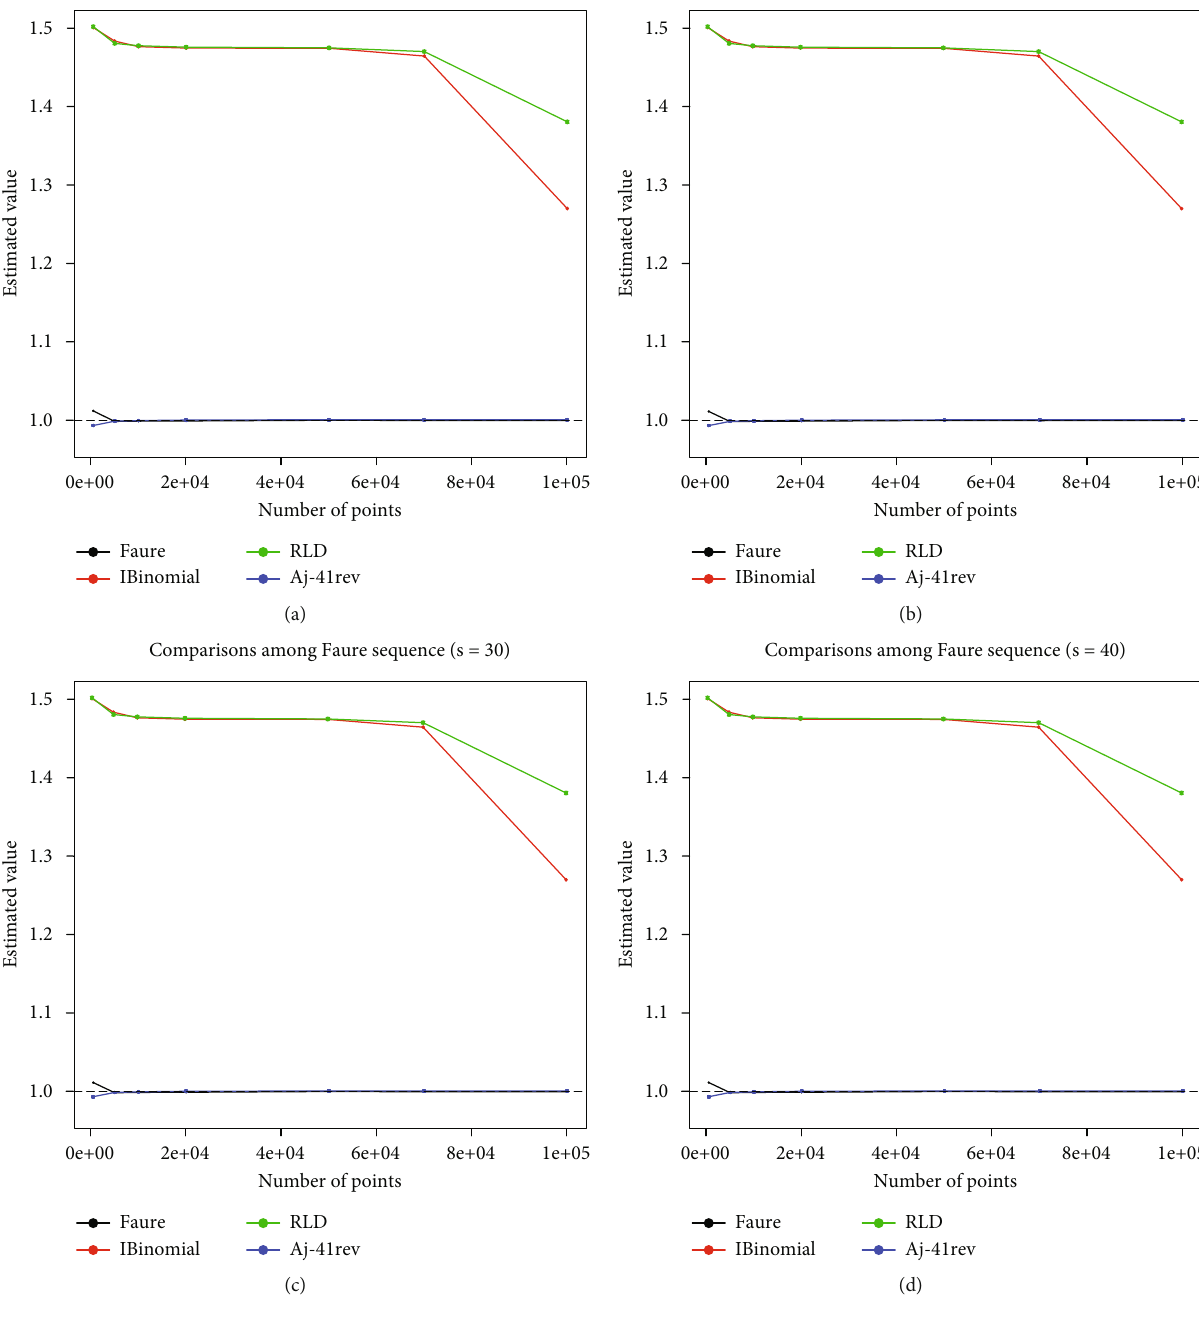
Figure 8: Estimates of the integral I